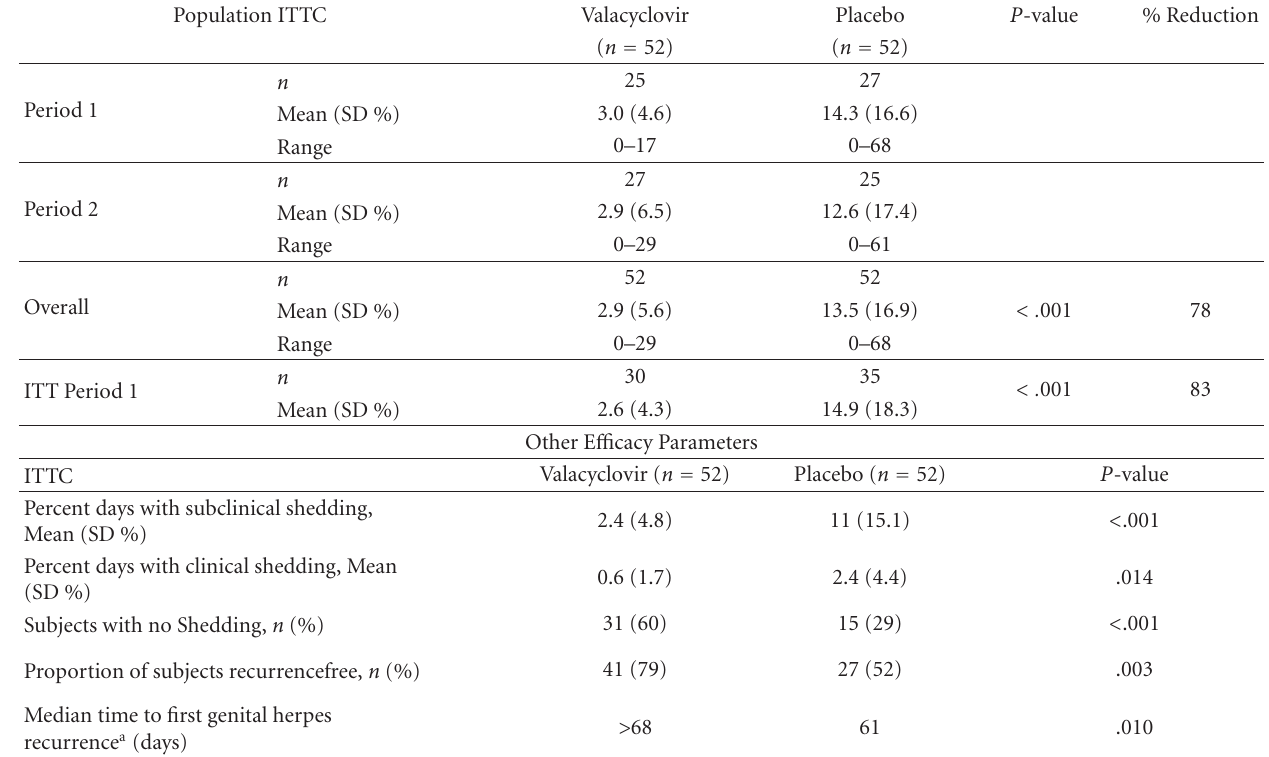
Table 2: Percent of Days with HSV-2 Viral Shedding.